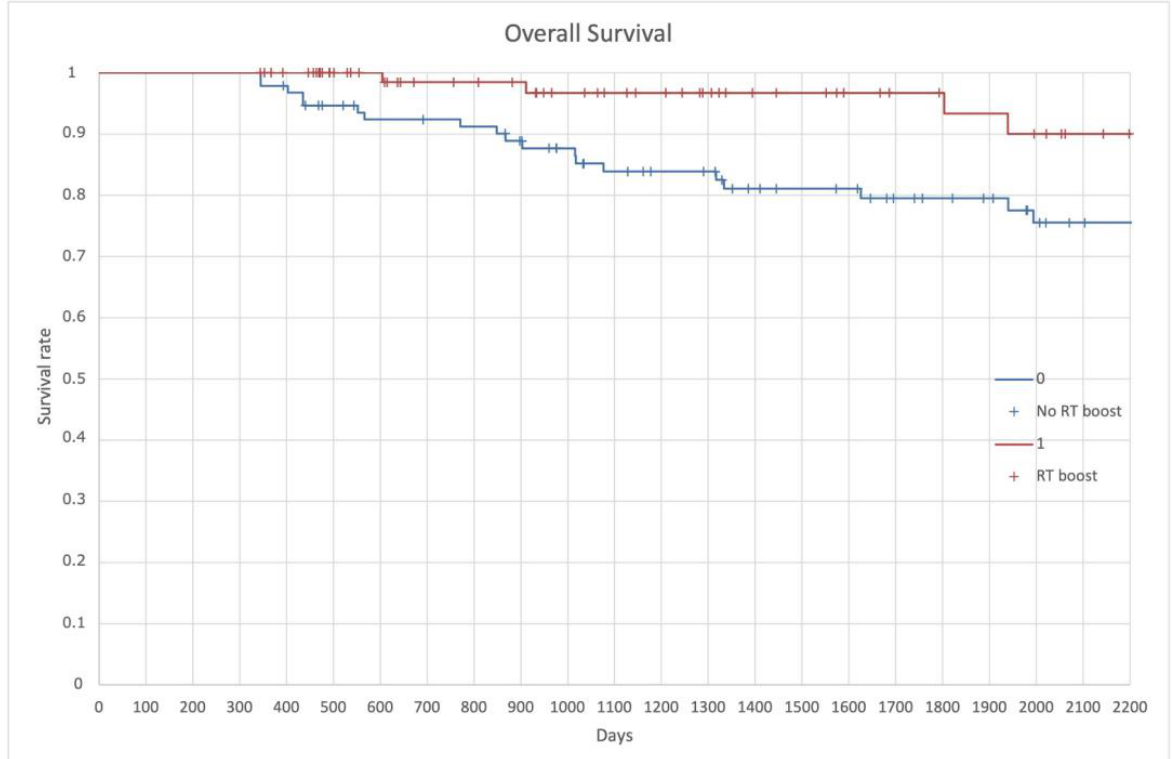
Figure 4. Overall Survival (OS).